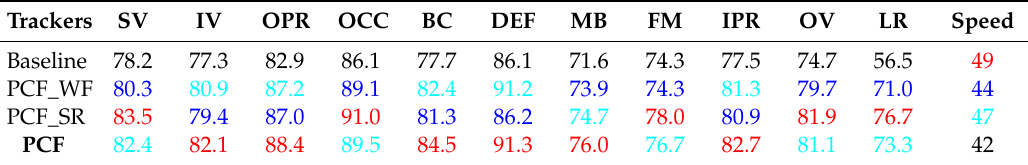
Table 2. The PP of the OPE for the baseline tracker, the proposed PCF tracker and the trackers of progressively integrating the presented strategies on eleven di ff erent attributes (the ranks of results are expressed in %): scale variation (SV), illumination variation (IV), out-of-plane rotation (OPR), occlusion (OCC), background cluttered (BC), deformation (DEF), motion blur (MB), fast motion (FM), in-plane rotation (IPR), out-of-view (OV), and low resolution (LR). The last column is the average running speed (FPS) on all sequences of OTB-2013. The top three ranks are marked in red , cyan , and blue respectively. Trackers SV IV OPR OCC BC DEF MB